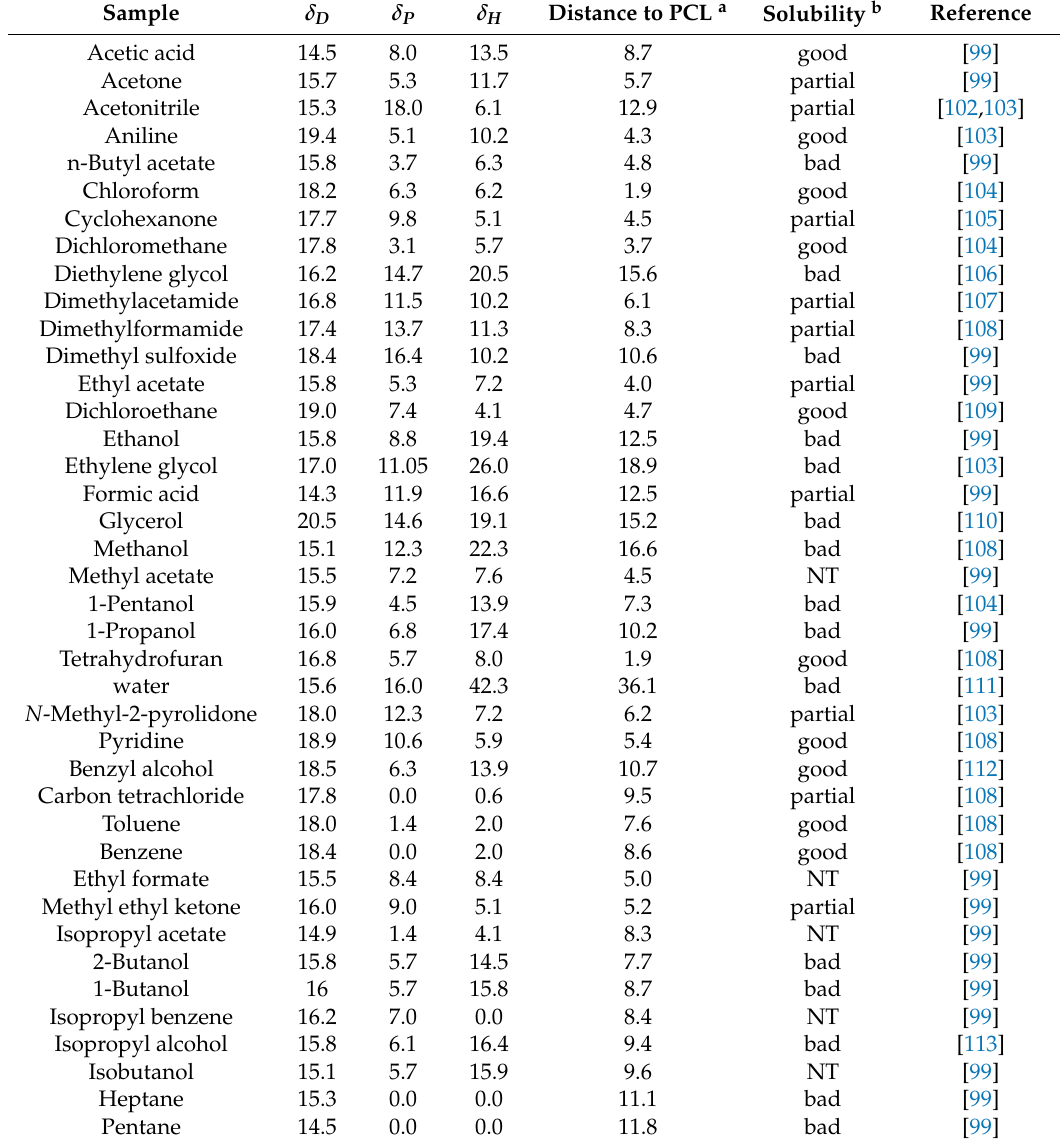
Table 2. Hansen solubility parameters of some common solvents and its solubility to PCL (part of the results obtained from swelling test and other part of results obtained from group distribution